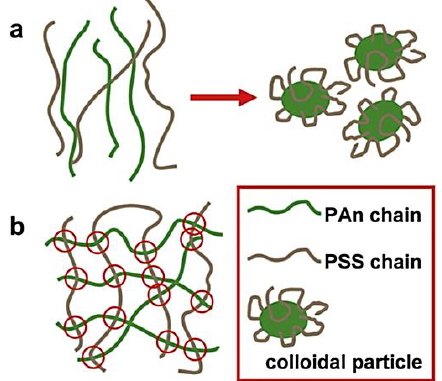
Figure 12. Illustration showing the effects of the reagent concentrations on the formation of the molecular networks. ( a ) In dilute solutions, PANI and PSS chains spontaneously assemble to colloidal particles. ( b ) In concentrated solutions, molecular network structures are formed and established. The red circles denote the linking points of the networks, where the interactions between the polymer chains take functions. Reproduced with permission [87].